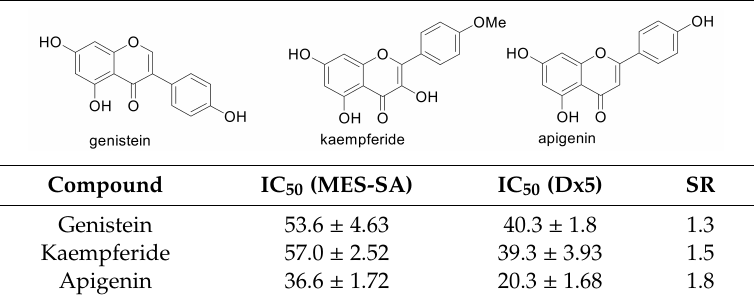
Table 2. The e ff ect of naturally occurring flavonoids on the sensitive MES-SA cell line and the resistant MES-SA / Dx5 line. IC 50 values are in µ